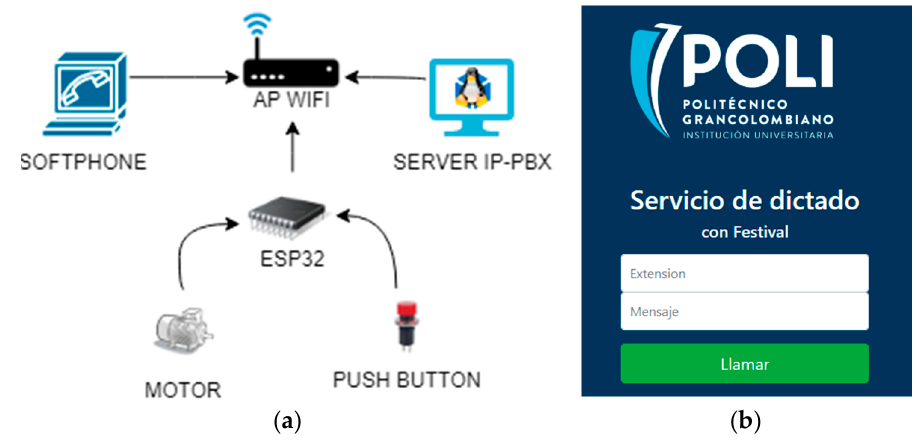
Figure 1. ( a ) Device topology; ( b ) web form.